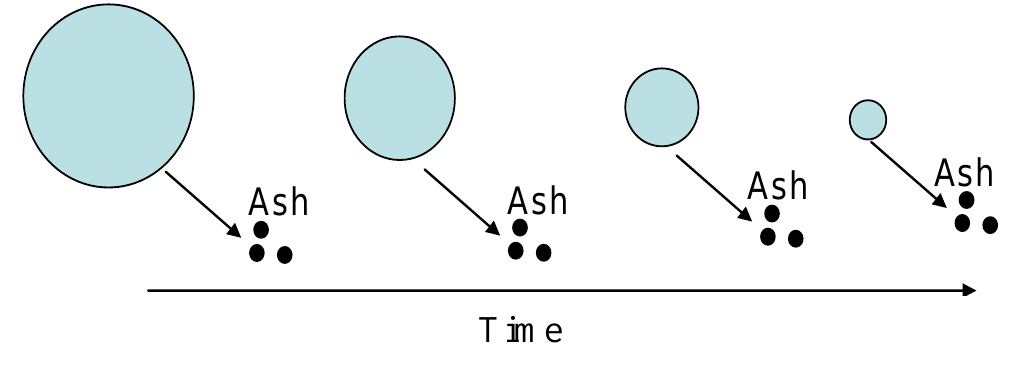
Figure 30. Particle Time History in Circulating Fluidized Bed Riser.